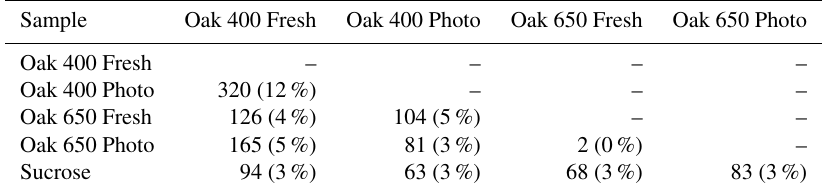
Table 1. Overlap of bio-produced molecular formulas among samples. The number of formulas corresponds to the formulas in common between the two samples being compared, and the percentage is relative to the total number of formulas in the two formula sets.